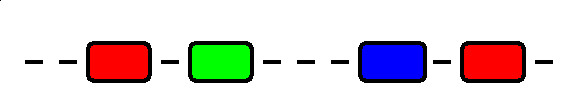
Max-gap cluster – module without organizational constraints. A max-gap cluster of motifs as a module without organizational constraints. The length of the sequence (l) is 16 bases, the number of motifs (m) is four, the widths of each motif (wi) is two bases and the max-gap (g) is three bases.